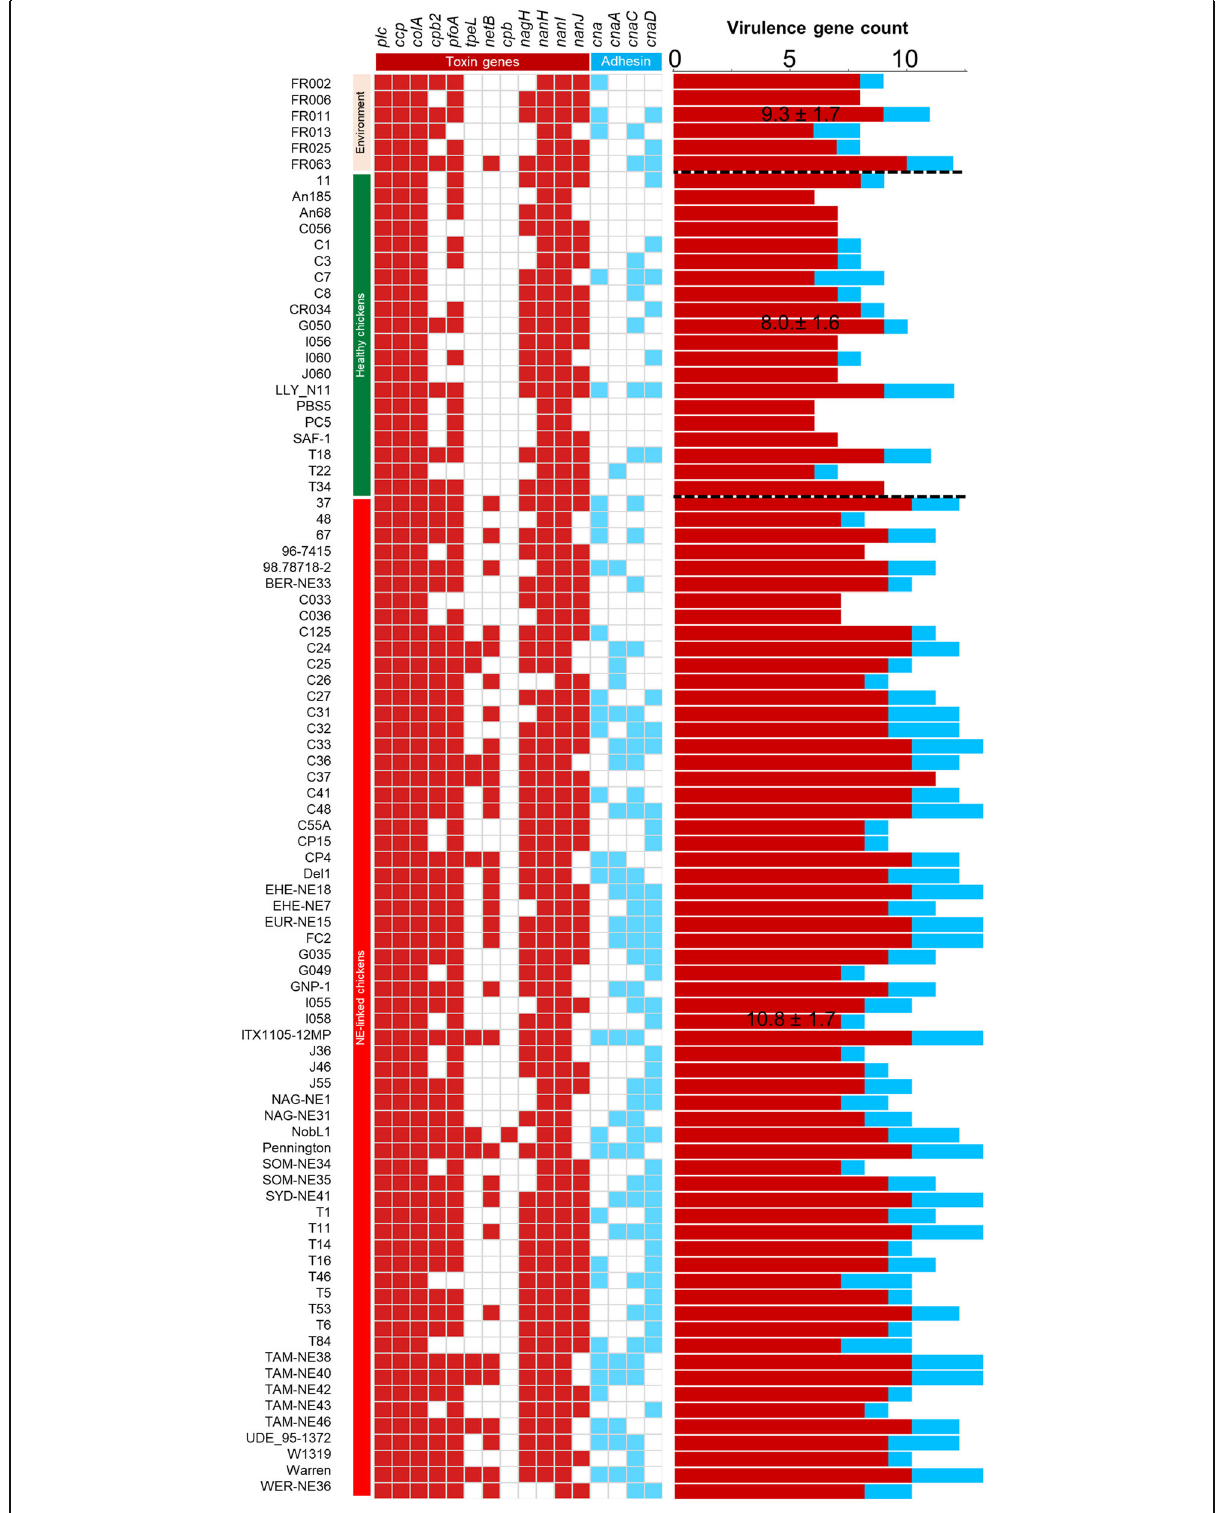
Fig. 4 Virulence profiles of toxin genes and collagen adhesin genes categorised by host health states of bacterial isolates. Coloured cells indicate presence of gene. Data: Mean ± S.D. in virulence gene count include toxin (red) and adhesin (light blue)